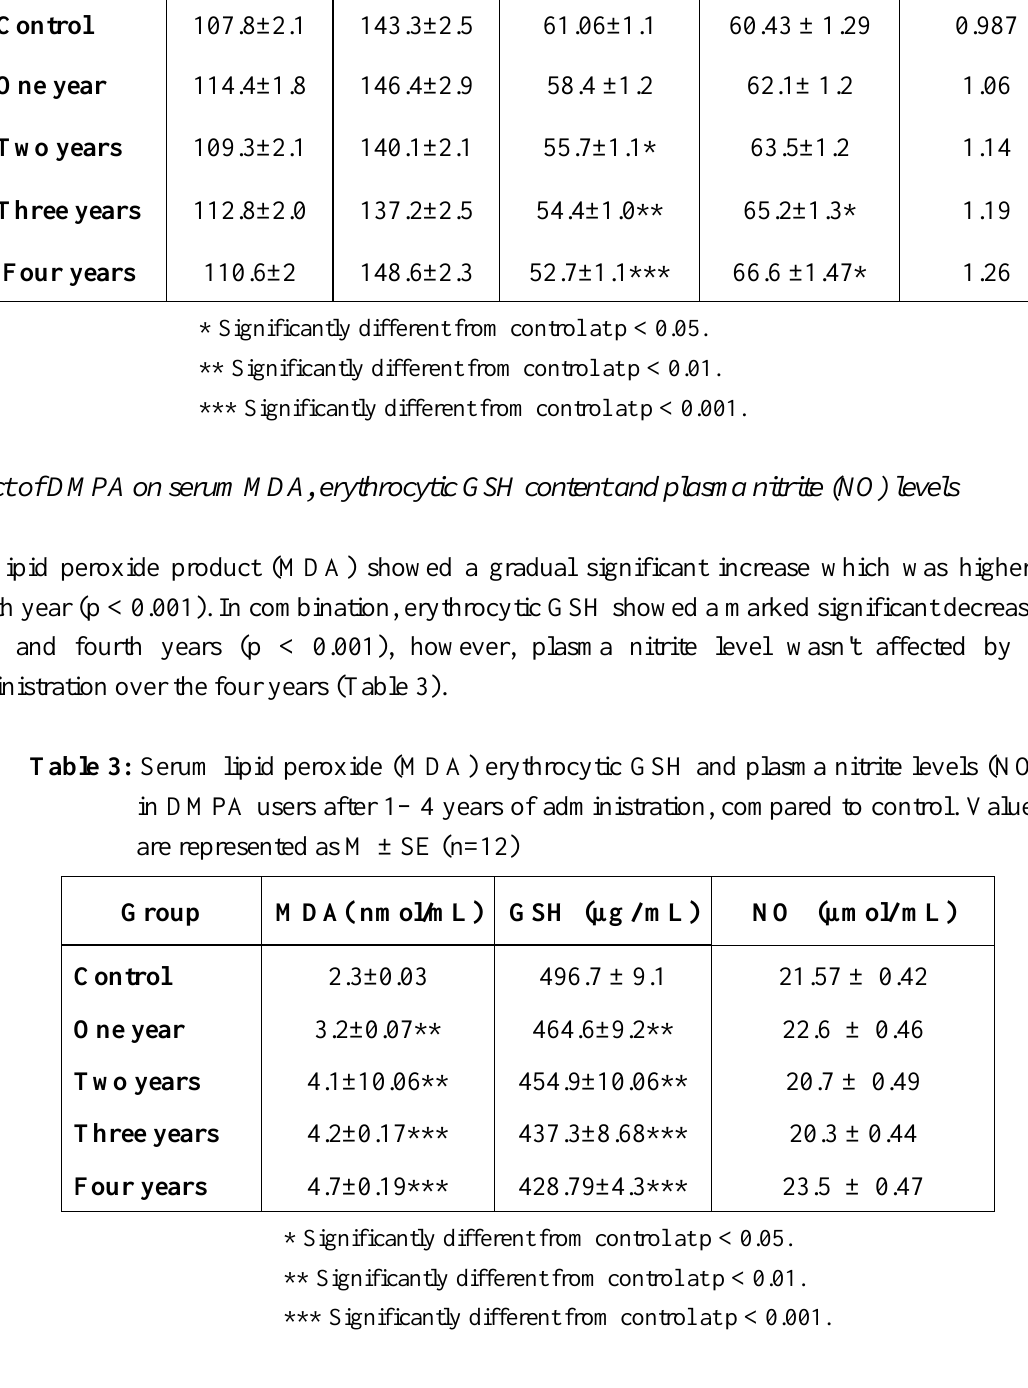
Table 2: Serum lipid profile in DMPA users after 1–4 years of administration, compared to control. Values are represented as M ± SE (n=12) Groups